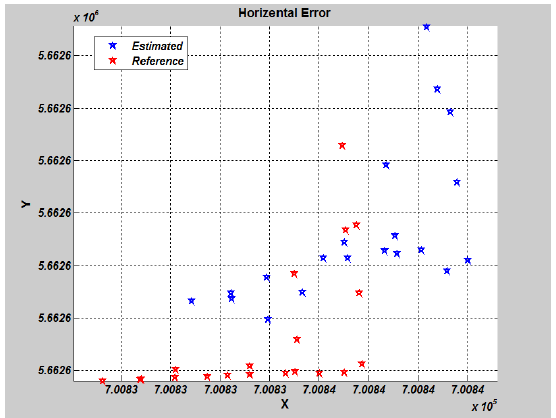
Figure 9. Horizontal error